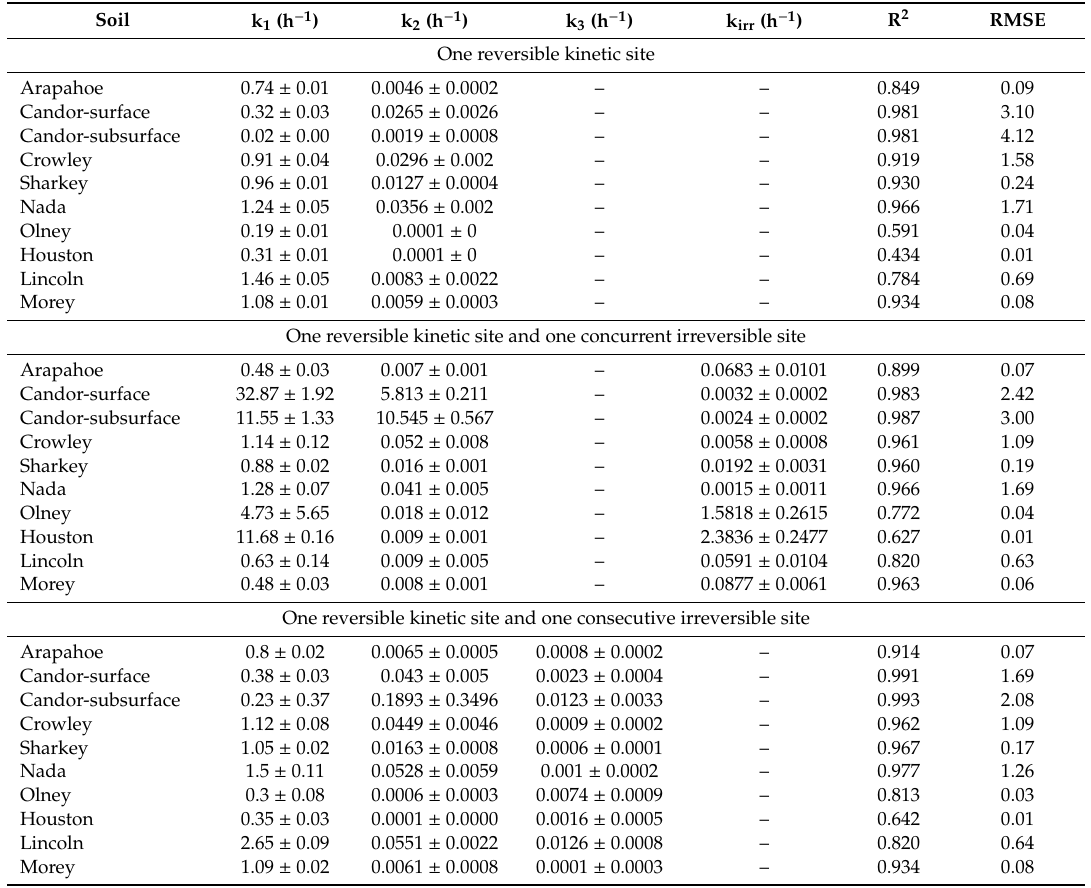
Table 3. Multireaction kinetic model (MRM) parameter estimates for Cu sorption / desorption of reaction rates (k 1 , k 2 , k 3 , and k irr ) ± their standard errors, with coe ffi cient of determination (R 2 ) and root mean square error (RMSE)